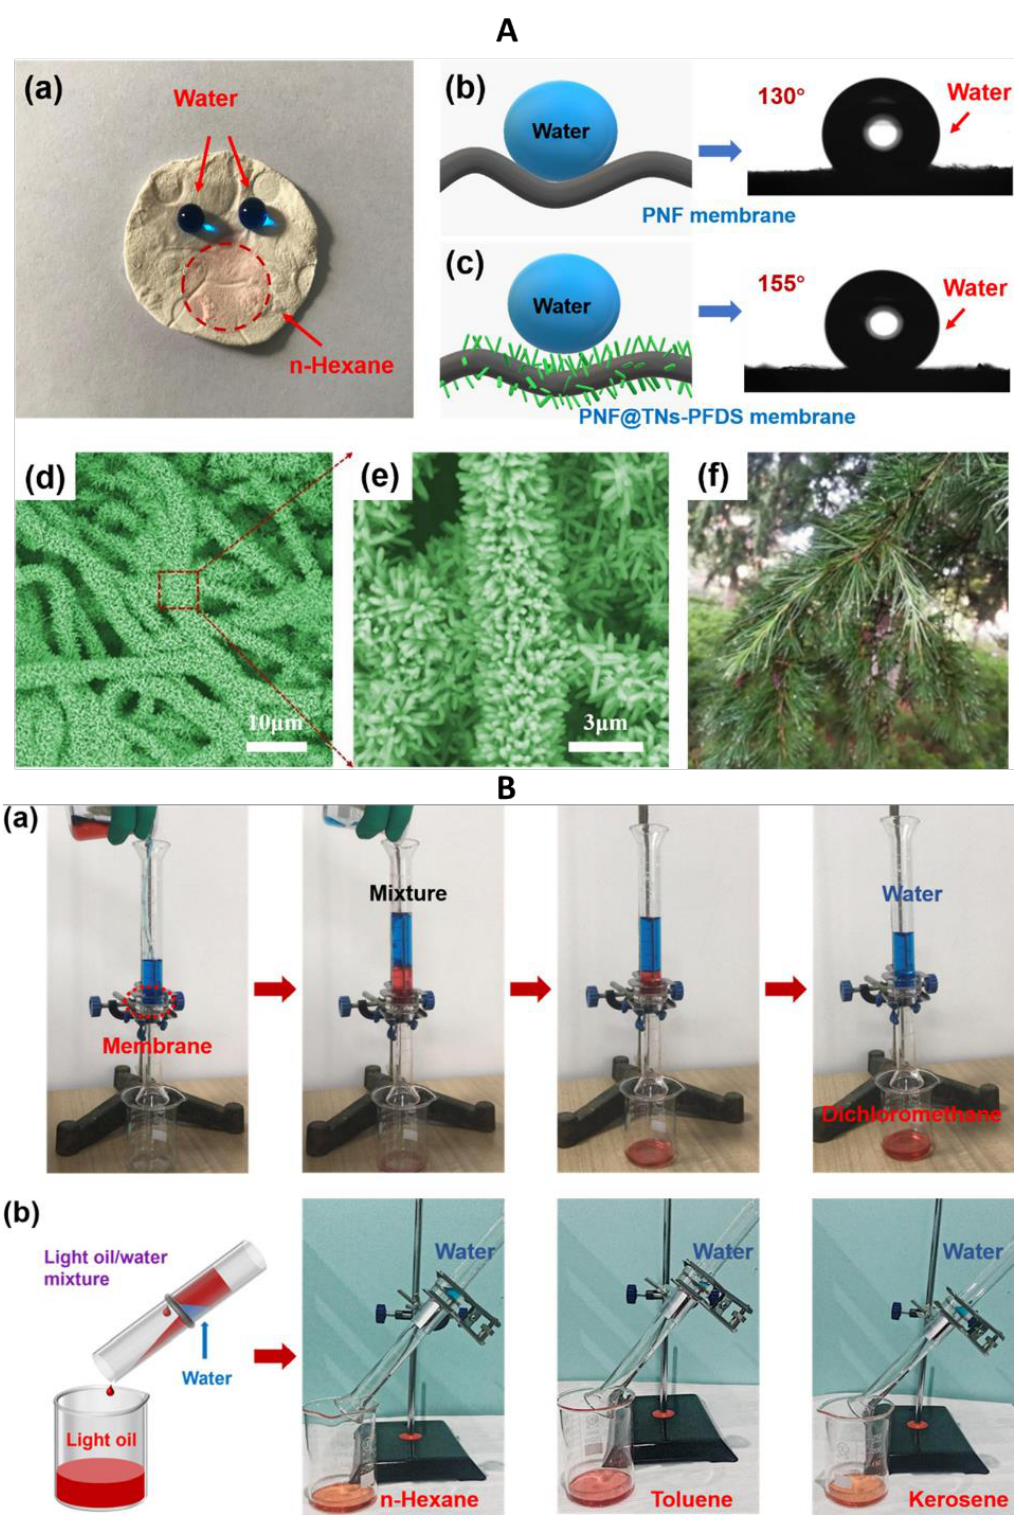
Figure 8. ( A ) (a) The state of water droplets and oil droplets (n-hexane) on the surface of the PNF@TNs-PFDS, the water, and the oil droplets were dyed to blue and red, respectively; (b) The WCA of PNF membrane; (c) PNF@TNs-PFDS fiber membrane; (d,e) SEM images of robust pine nee- dle-like TNs; and (f) Photograph of pine needle. ( B ) Oil/water separation process of (a) heavy oil and (b) light oil [122]. Reprinted with permission from Ref. [122]. Copyright 2021 Elsevier B.V.